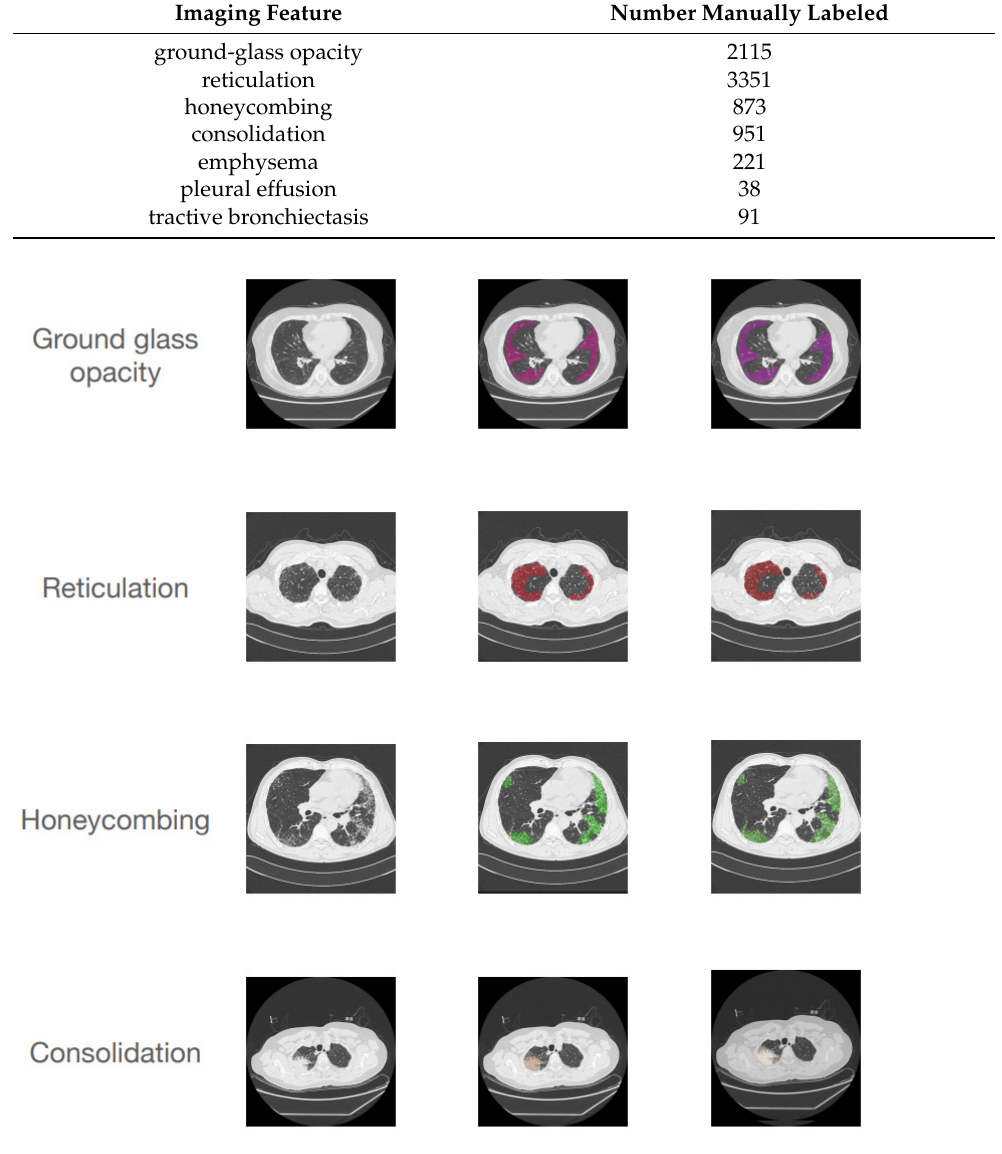
Table 1. Number of manually labeled imaging features.